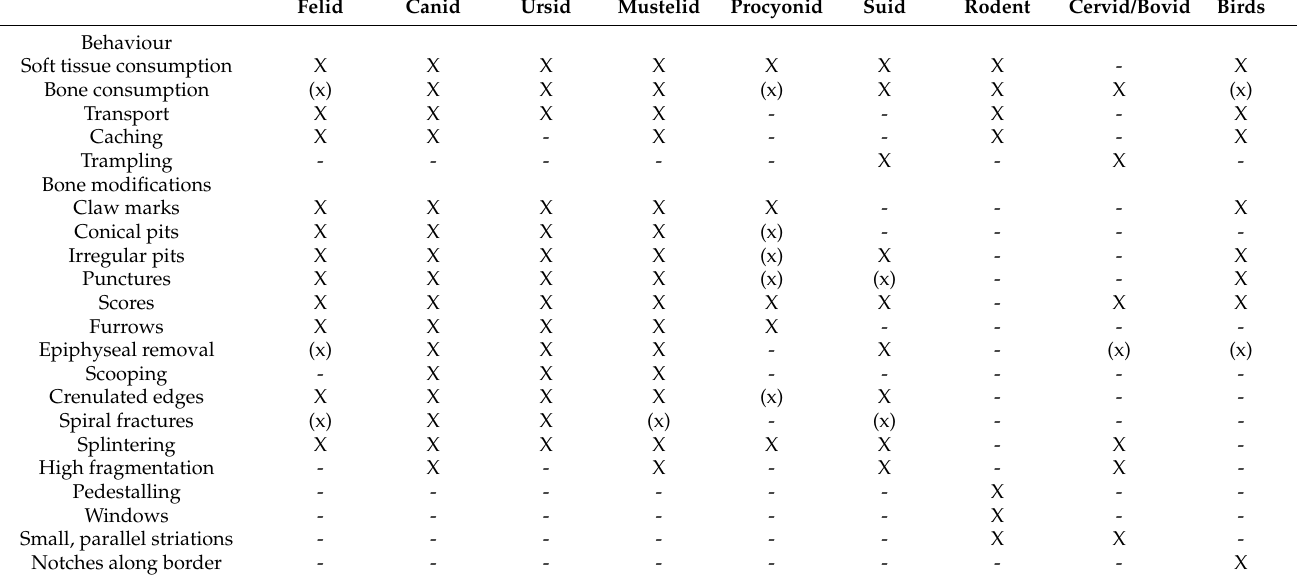
Table 1. Potential European vertebrate scavenger taxa of outdoor forensic scenes and their charac- teristic modifications on human tissue. X = typically present, (x) = may be present, - = typically not